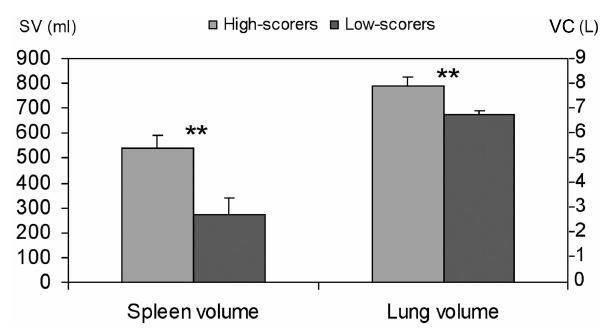
FIGURE 2 | Mean (SD) spleen volume (SV) and lung volumes vital capacity (VC) in highest ( n = 3) and lowest ( n = 3) scoring divers. Significance at P < 0.01 is indicated by **.